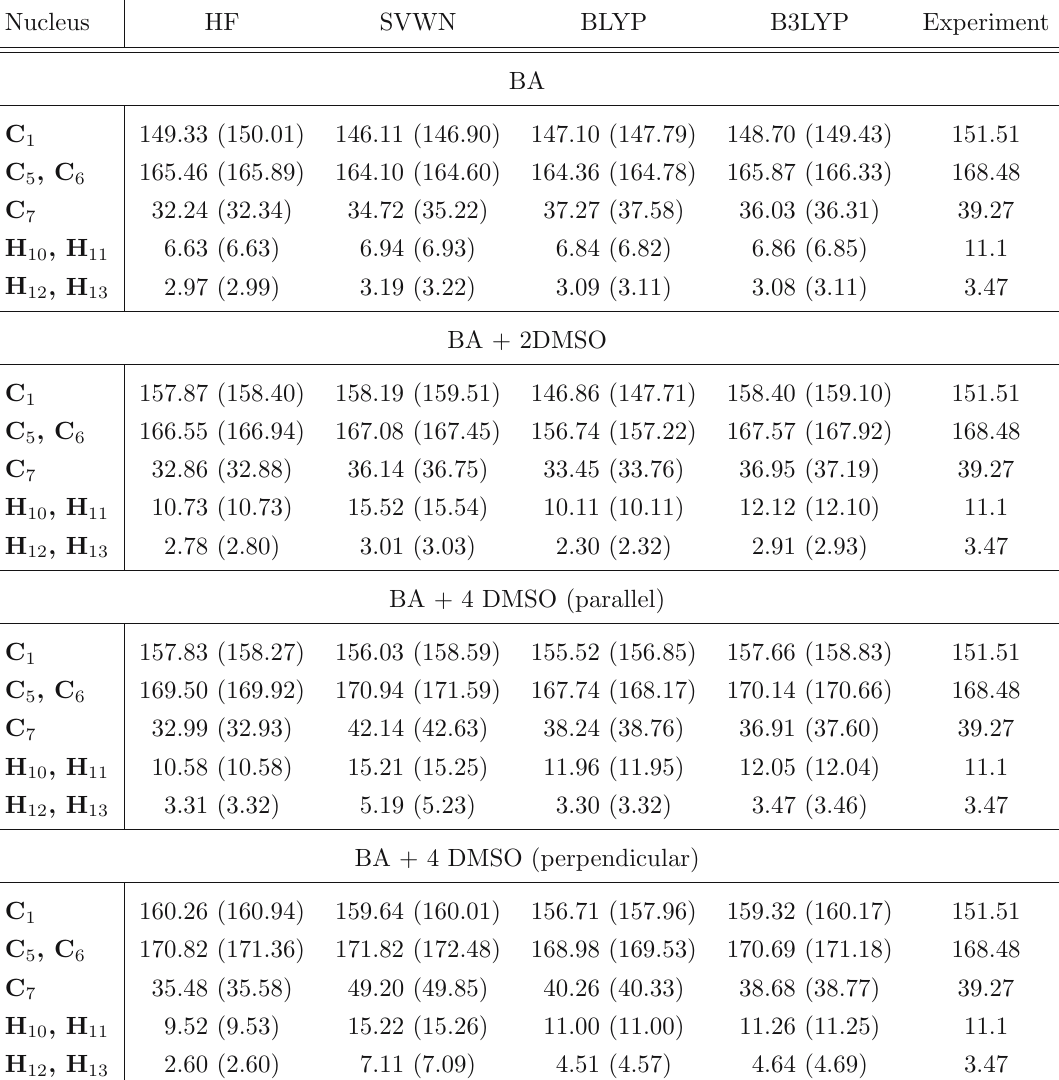
Table 2 Theoretical GIAO and CSGT (in parentheses) chemical shifts of barbituric acid and its complexes in the 6-311++G(3f,2pd) basis